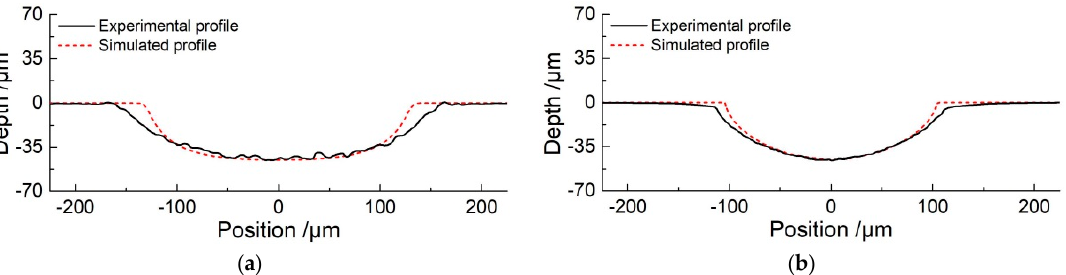
Figure 8. Profiles of micro-grooves in same depth fabricated with different masks. ( a ) Using the insulated mask ( P in = 0.8 MPa, U = 10 V, ε = 20%, f = 1 kHz, t on = 10 s); ( b ) Using the conductive mask ( P in = 0.8 MPa, U = 35 V, ε = 20%, f = 1 kHz, t on = 20 s).